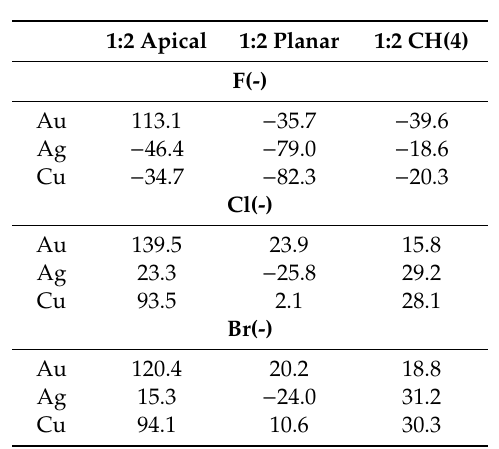
Table 3. Binding energies (kJ mol − 1 ) of the 1:2 complexes, (Pz-M) 3 : X 2 − at the MP2 / aug’-cc-pVDZ computational